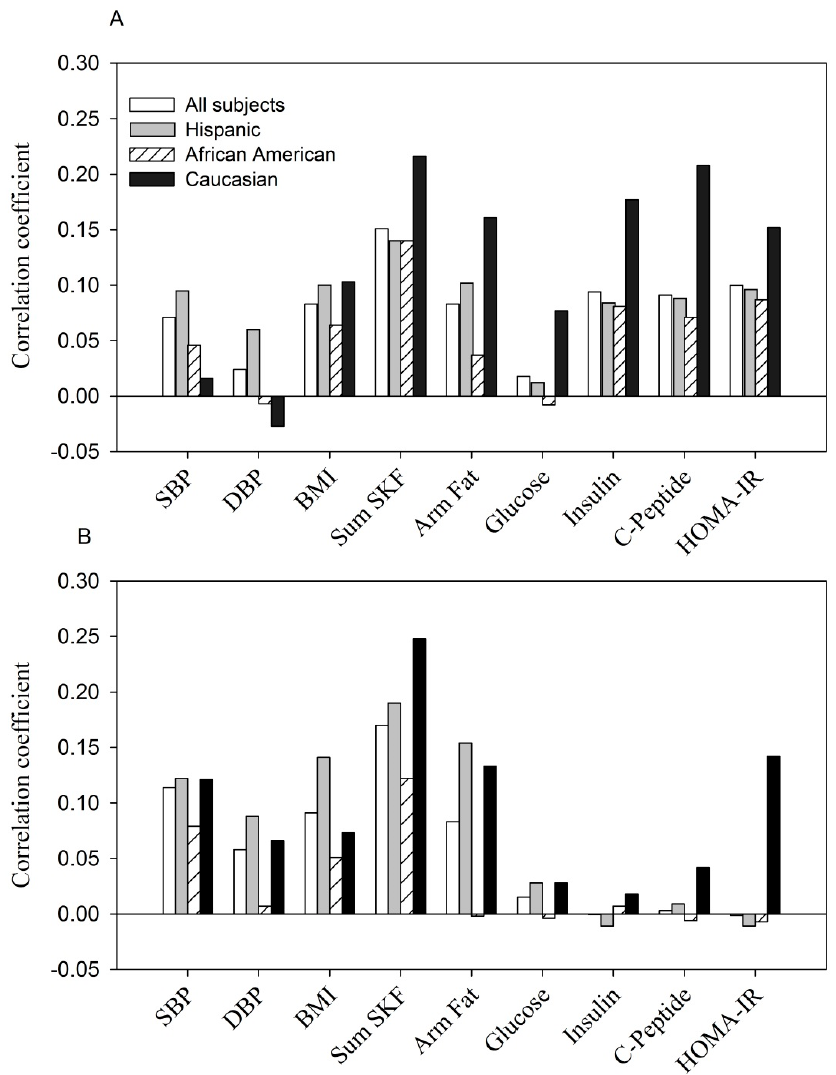
Figure 2. ( A , at entry; B , during the 3rd trimester). The relationship between serum resistin (ng/mL) with anthropometric and glycemic parameters.